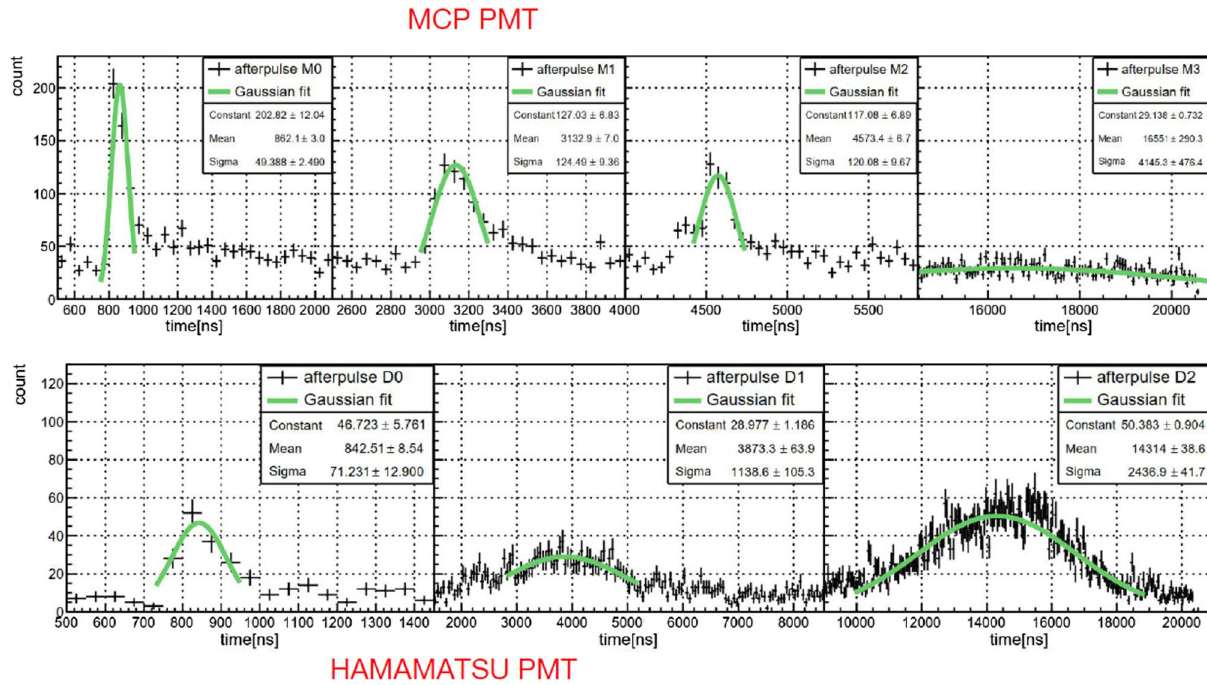
Fig. 29 Typical time features of after-pulses for two typical PMTs. Top: NNVT; bottom, HPK (Hamamatsu)